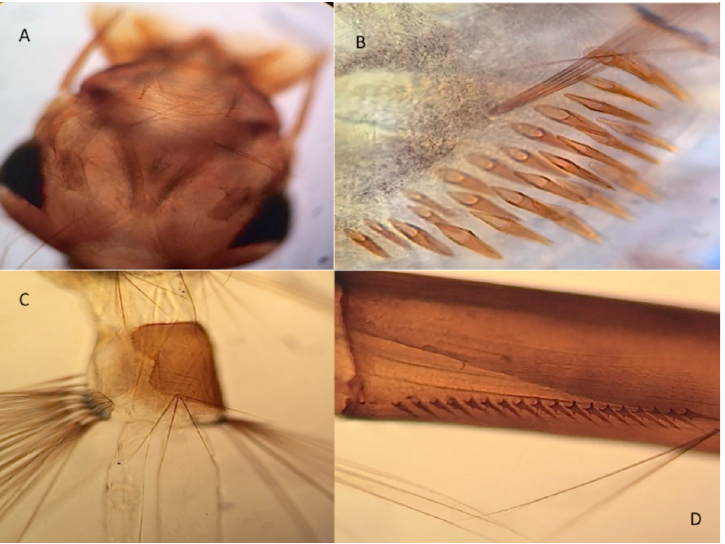
Fig 8. Larva of Aedes ( Protomacleaya ) lewnielseni . A: Head (dorsal view). B: Comb scales. C: Segment X. D: Pecten of